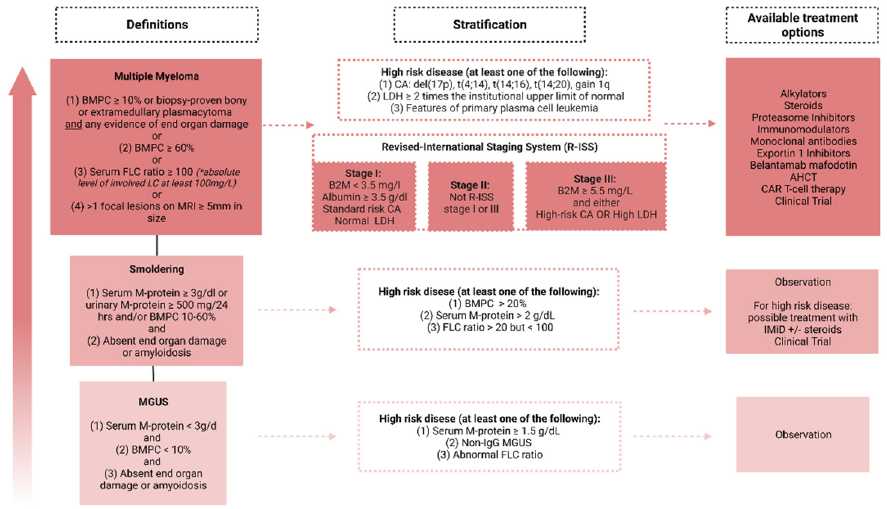
Figure 2. Clinical definitions, risk stratification, and available therapies for multiple myeloma and preexisting plasma cell disorders. End organ damage is defined as: Hypercalcemia (serum calcium >1 mg/dL higher than the upper limit of normal or >11 mg/dL); renal insufficiency, creatinine clearance < 40 mL/minute or serum creatinine > 2 mg/dL; anemia with a hemoglobin value > 2 g/dL below the lowest limit of normal or a hemoglobin value < 10.0 g/dL; and Bone lesions, ≥ 1 osteolytic lesion on imaging. Abbreviations: M, monoclonal; BMPC, Bone Marrow Plasma Cells; FLC, Free Light Chain; B2M, Beta-2 Microglobulin; CA, Cytogenetics, IMiD, Immunomodulators; AHCT, Autologous Hematopoietic Cell Transplantation; CAR, Chimeric Antigen Receptor.